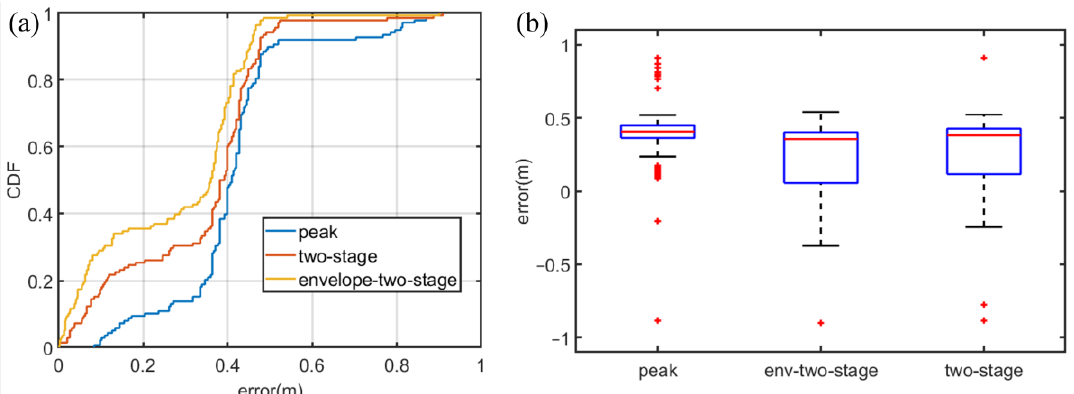
Figure 26. Experiment results in the situation of NLoS by people. ( a ) CDF of experimental error. ( b ) box figure of experimental error.